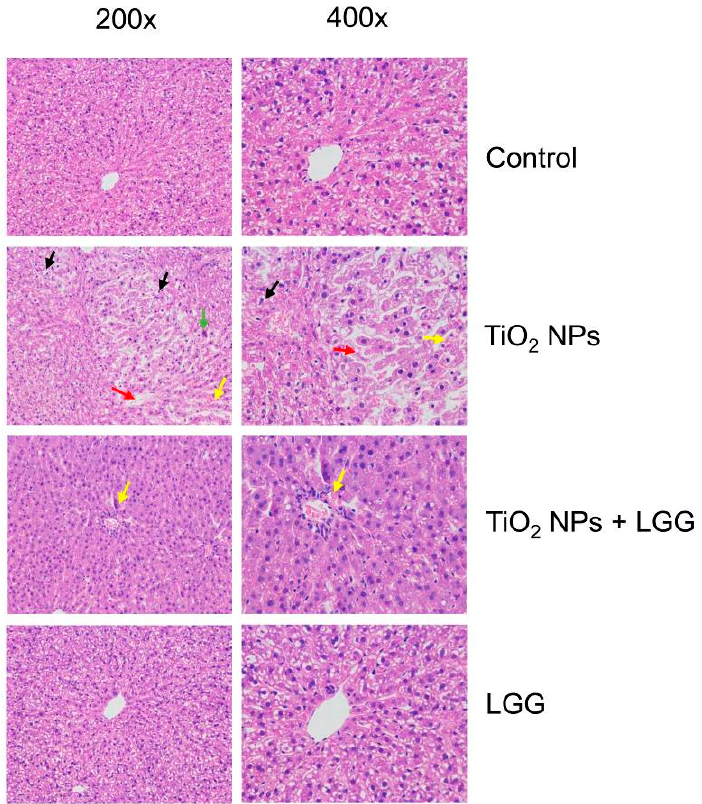
Figure 6. Sections of the liver with HE stained at 200 × and 400 × of young rats after oral exposure to TiO2 NPs. (black arrows: hepatocytes ballooning degeneration; blue arrows: eosinophilic; red arrows: hepatocytes appear arrangement disordered; yellow arrows: blood cells).